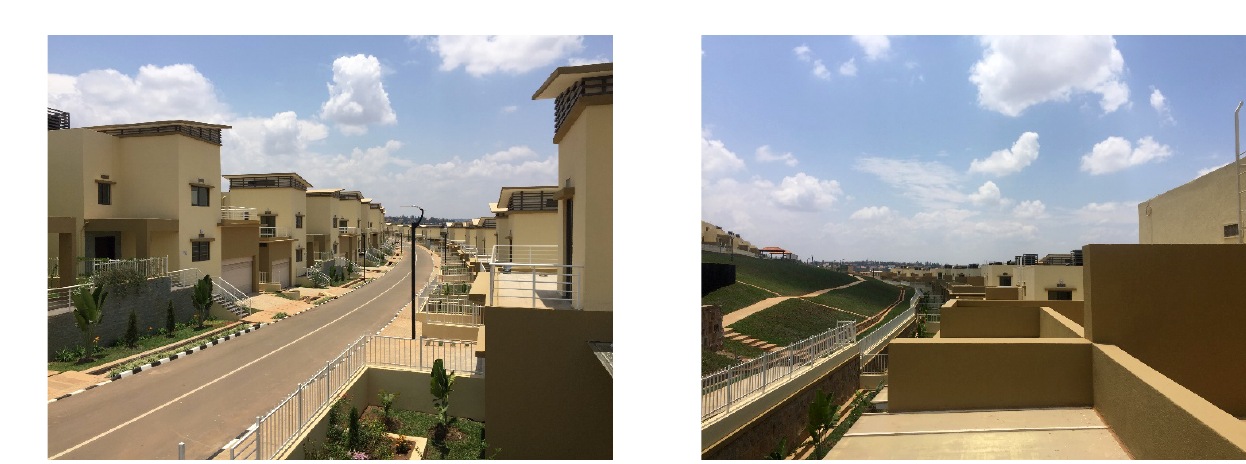
Figure 54. The Umudugudu Kigali Vision: Twin houses (3–4 Bedrooms); front yard. Photograph by Manlio Michieletto.